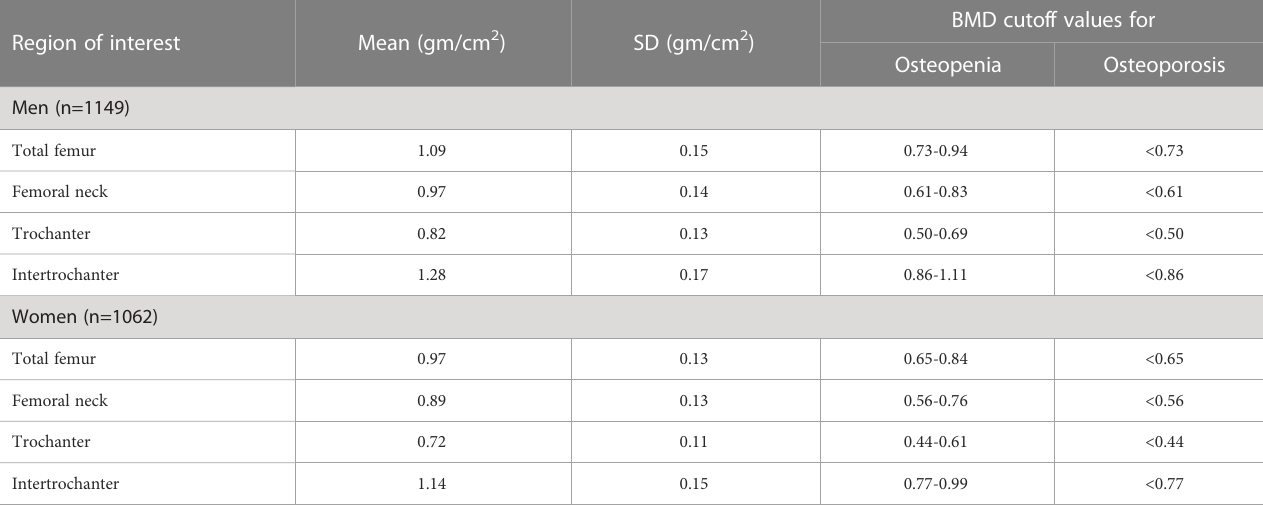
TABLE 1 Mean femoral bone mineral density (BMD) of 20 – 29-year-old men and women in NHANES 2005 – 2010, 2013 – 2014, and 2017 – 2018.